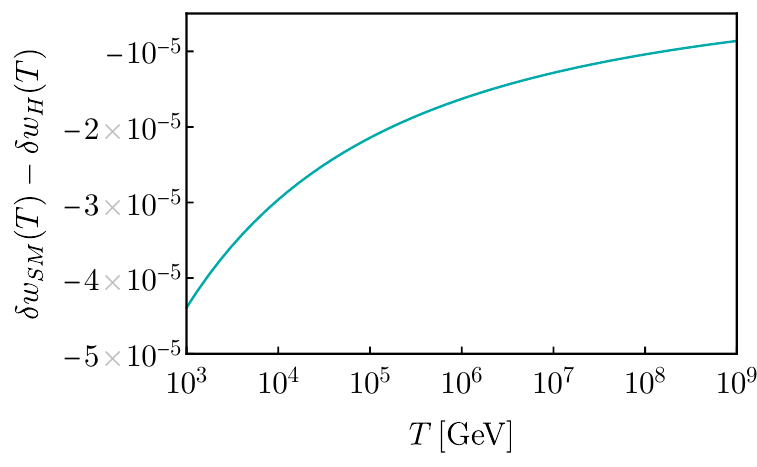
Figure 11 . The difference in the equation of state of the Standard Model with and without a vector-like doublet dark